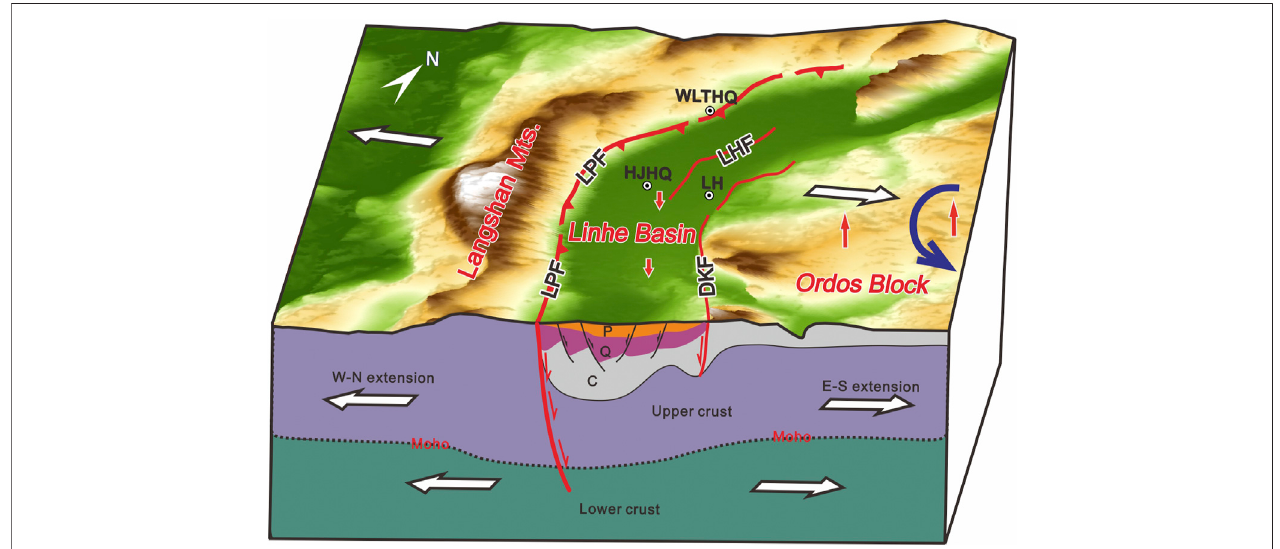
FIGURE 8 | Graphic of the tectonic movement mode in the Langshan Mountain-Linhe Basin area on the northwestern edge of the Ordos Block. The blue arrow represents the counterclockwise rotation of the Ordos Block; Moho quoted from Chen et al. (2020). P, Pleistocene; Q, Quaternary; C, Cenozoic (State Seismological Bureau,